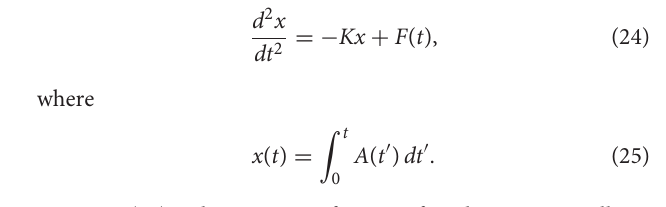
FIGURE 1 | (Color ) Time evolution of the mean square displacement (in arbitrary units) for normal and anomalous diffusion. For the upper curve α (superdiffusion), for the middle curve α Review Letters.